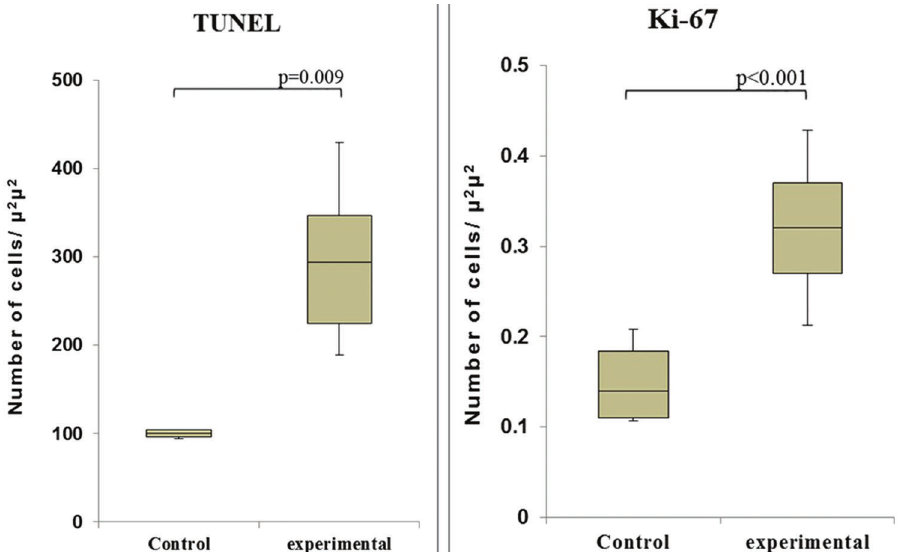
Figure 4 - The numbers of apoptotic cells (left - TUNEL assay) and proliferating cells (right - Ki-67 staining) in the control and I/R-injured groups (60 min after